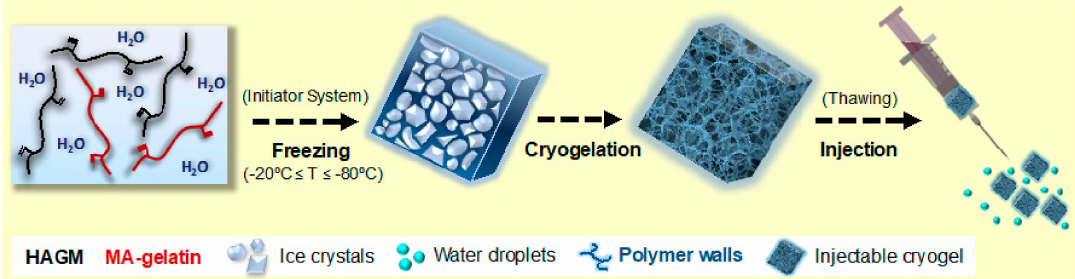
Figure 2. Schematic depicting the fabrication process of injectable HA- co -Gelatin cryogels. HAGM and/or MA-gelatin are dissolved in water containing an initiator system (APS and TEMED), and subsequently frozen at three different subzero temperatures ( − 20, − 50 and − 80 ◦ C). The cryopolymerization and gelation of polymers occur around ice crystals, leaving interconnected voids behind upon melting. Rhodamine-labeled HAGM or MA-gelatin were incorporated only for microscopy imaging. Fabricated macroporous cryogels (4 mm × 4 mm × 1 mm) can then be easily and successfully syringe-injected through a 16-gauge hypodermic needle.